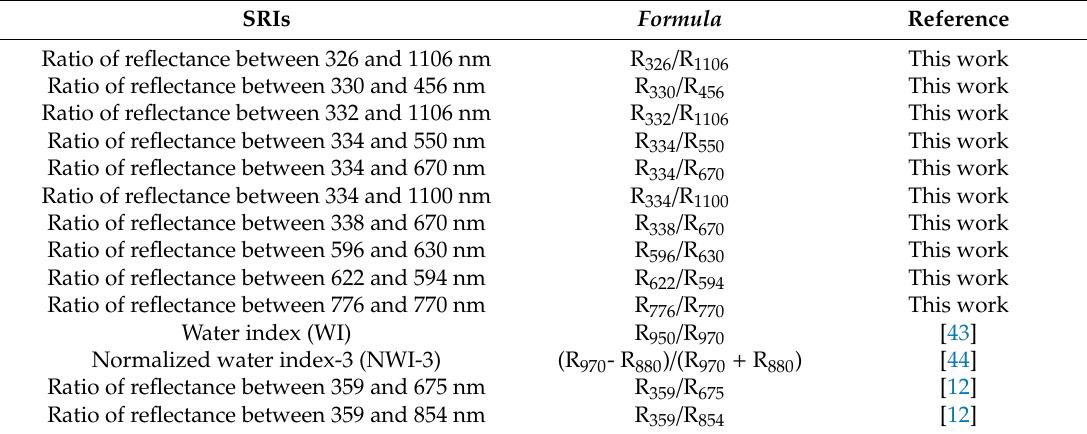
Table 2. Formula and references of di ff erent spectral reflectance indices (SRIs) developed in this study and selected from the